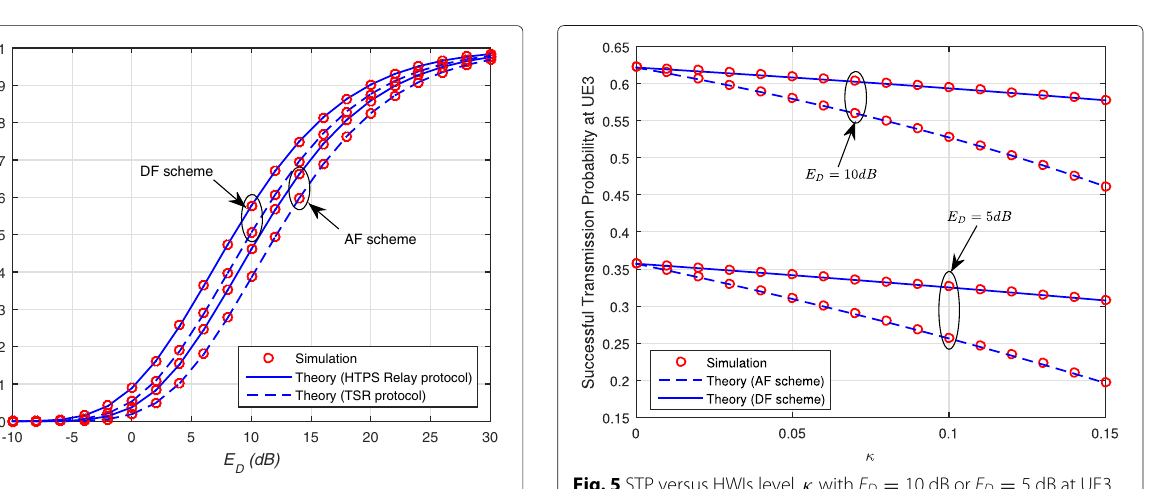
Fig. 3 STP versus E D (dB) at UE3